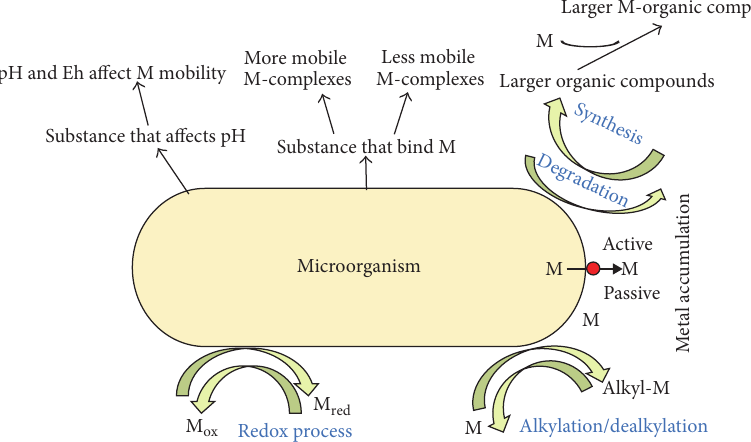
Figure 4: Metal accumulation process by microorganisms and its influence on metal